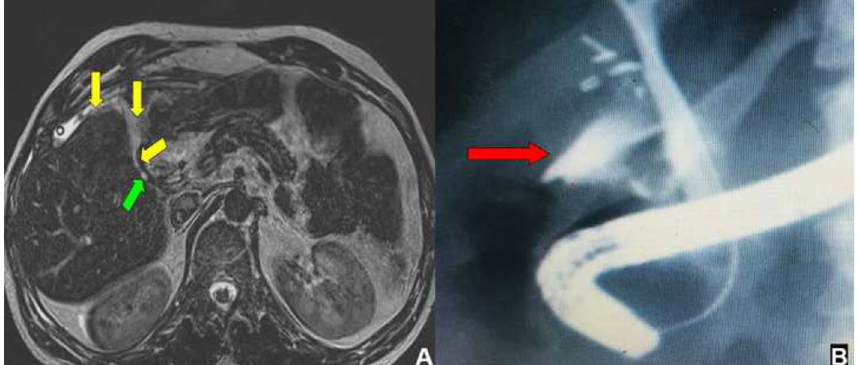
Fig. 11 Axial thin cuts MRCP ( a ) post-cholecystectomy biliary leaked “yellow arrows” adjacent to the extrahepatic biliary tree with suspected injury to the main bile duct “green arrow”. Strasberg Type D bile duct injury. ERCP image ( b ) demonstrates contrast extravasation from the lateral aspect of common bile duct with still preserved duct continuity confirming the previous finding “red